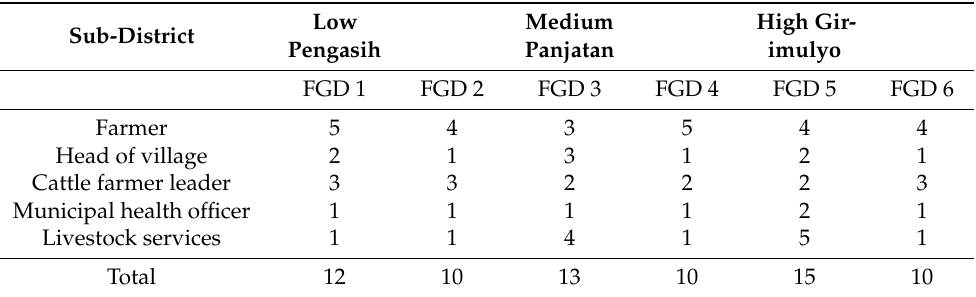
Table 2. Overview of the participants in focus group discussions (FGDs) conducted in low, medium and high-risk